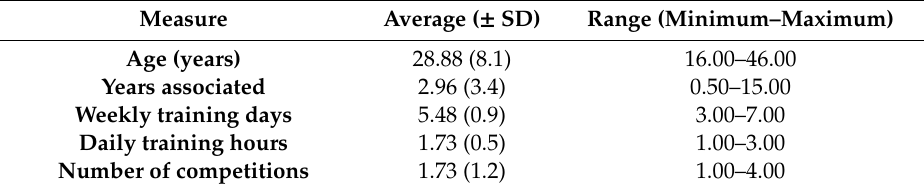
Table 1. Training and bodybuilding competition characteristics of the